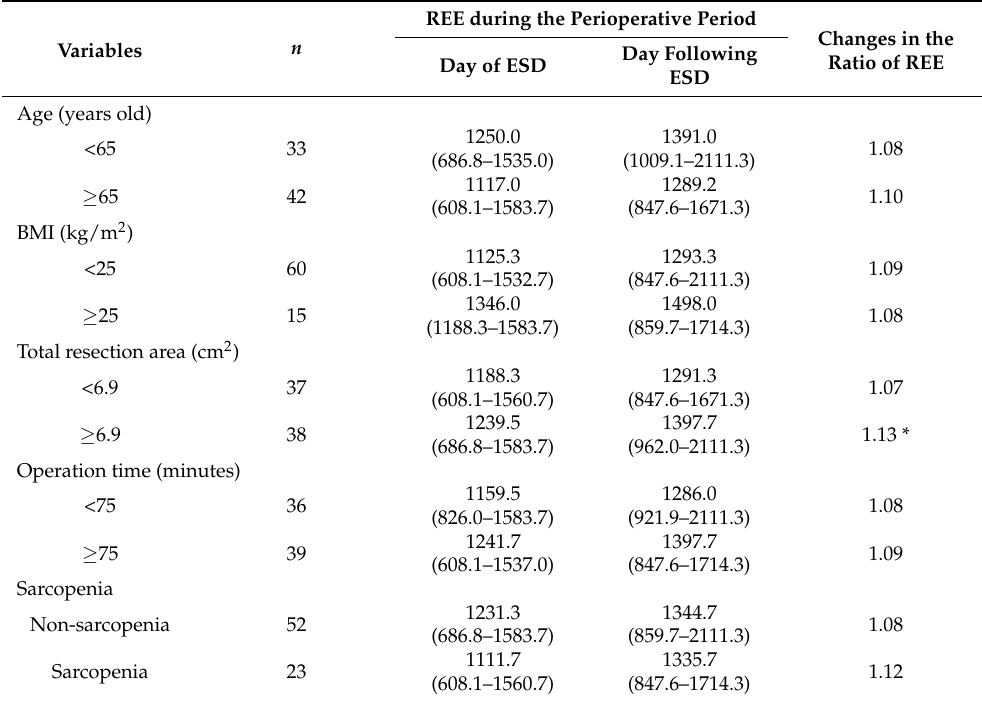
Table 4. Univariate analysis for the factors associated with REE during the perioperative pe- riod of ESD.